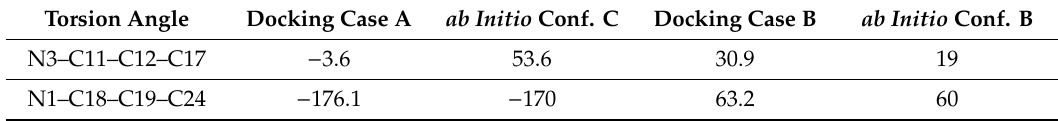
Table 4. Torsion angles of ligands obtained by ab initio and docking (5E0I protein) calculations. Torsion Angle Docking Case A ab Initio Conf. C Docking Case B ab Initio Conf.